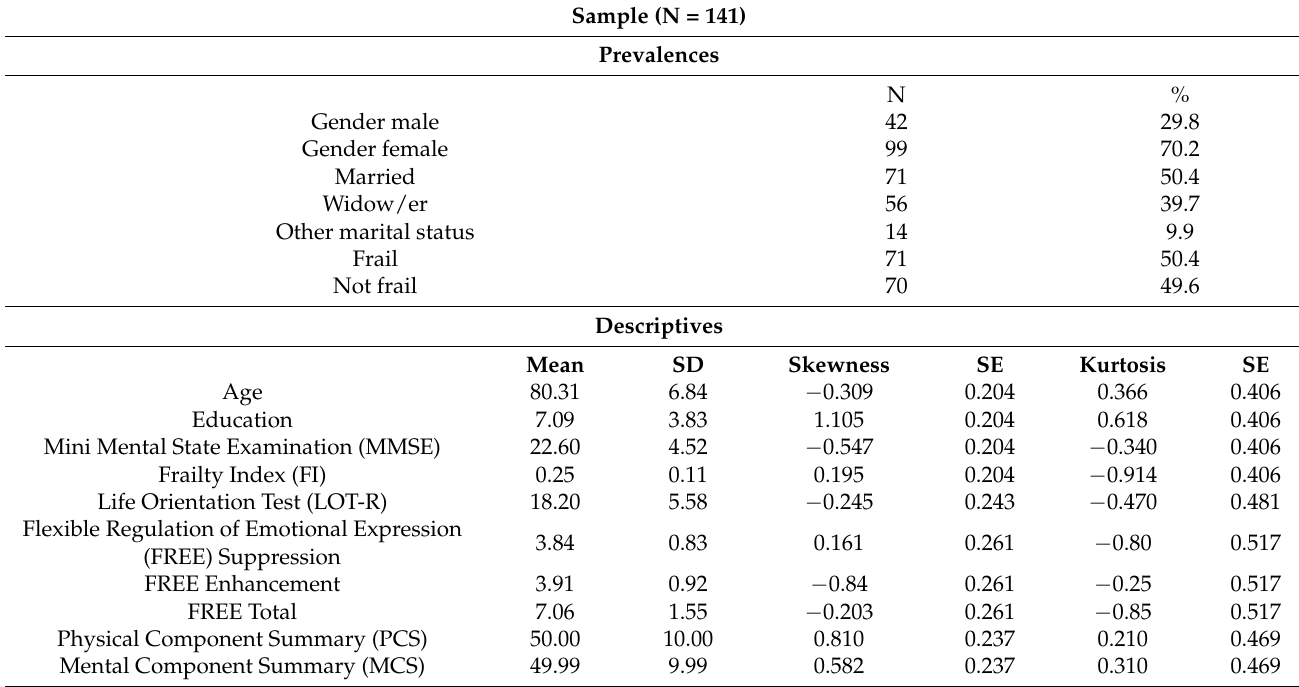
Table 1. Main sociodemographic and clinical baseline characteristics of the